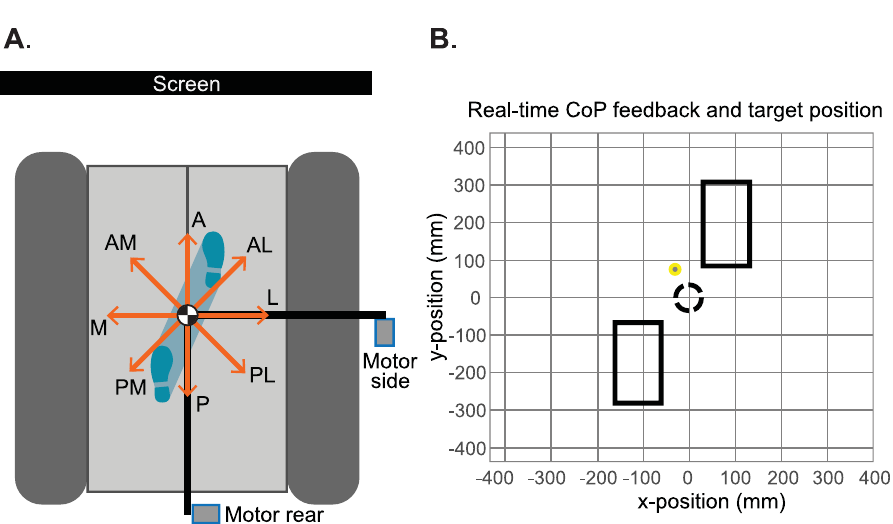
Fig 1. Experimental setup. A) Schematic top-down view of the setup, with one motor (side) placed to the right of the participant, and the other motor (rear) placed posterior of the participant. The orange arrows indicate the 8 perturbation directions. A = anterior, P = posterior, M = medial, L = lateral, AM = anterior-medial, AL = anterior- lateral, PM = posterior-medial, PL = posterior-lateral. A screen is placed directly in front of the participant displaying the position of their feet and CoP as well as the desired CoP position in real-time. B) Feedback presented on the screen. Top-down view of the participant’s feet depicted with the rectangles, based on the position data of the 1 st and 5 th metatarsi together with the calcanei. The yellow dot presents the participant’s CoP. The black dashed circle is the desired CoP